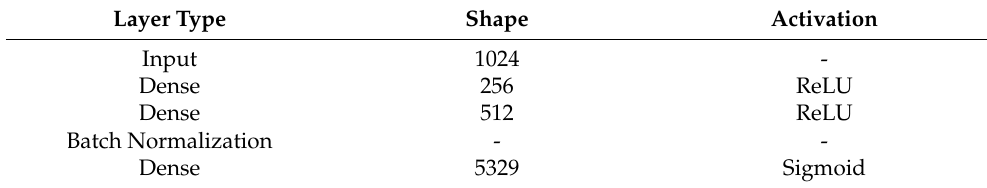
Table 2. The architecture of the fully connected neural network